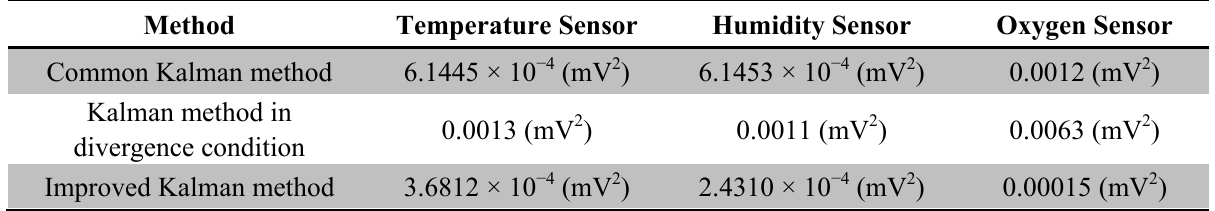
Table 1. MSE between measured data and the a posteri estimated